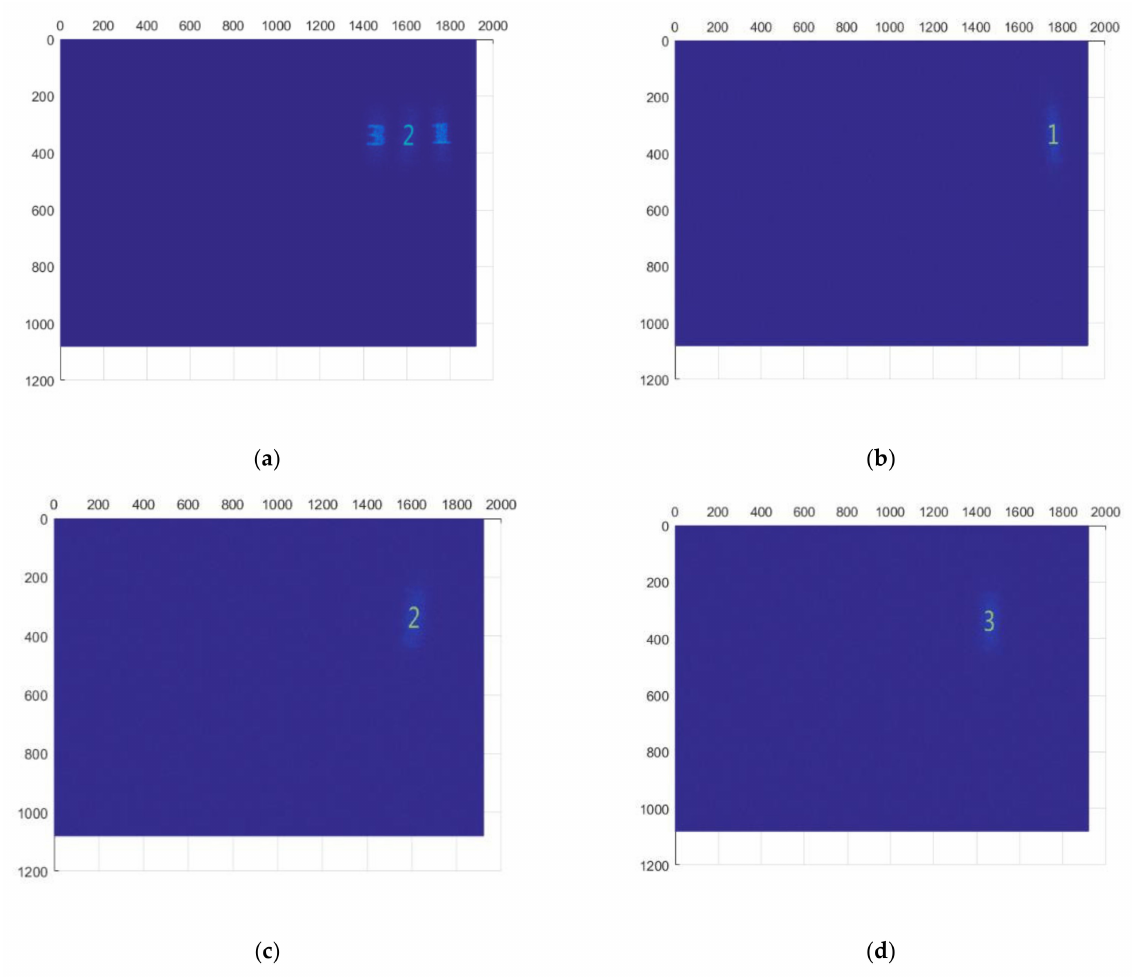
Figure 13. Front view analysis results ( a ) without phase-locked algorithm and ( b – d ) with phase- locked algorithm.